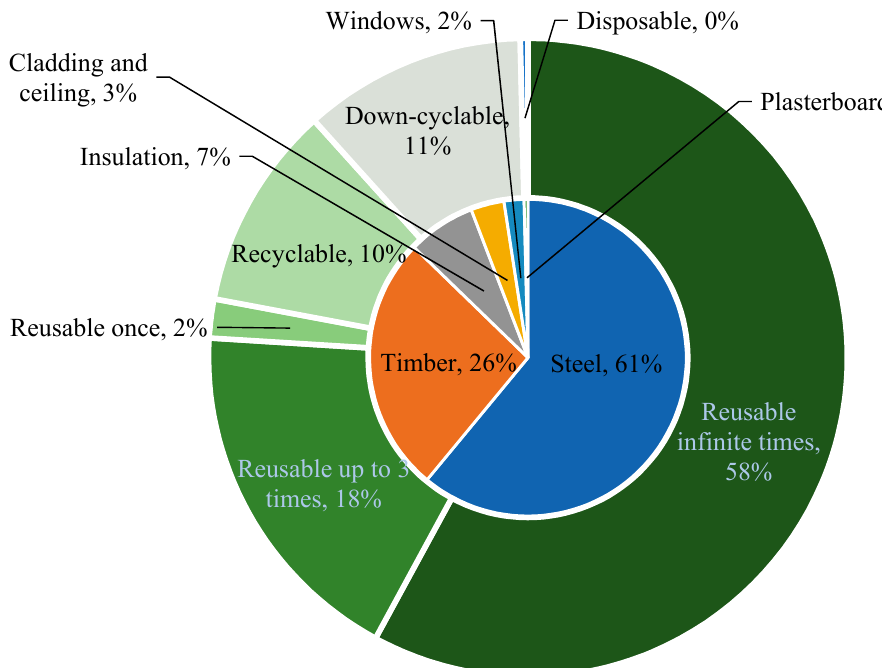
Figure 3. Pie and doughnut chart of material and subsequent product use of materials used in the Legacy Living Lab.